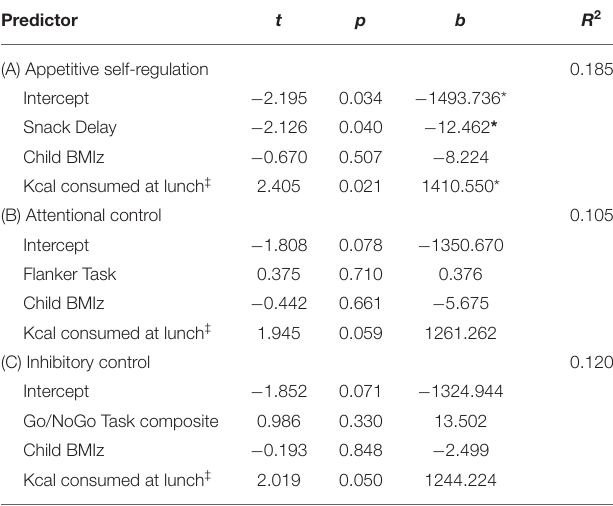
( Table 3B ), nor was inhibitory control, b = 13.50, 95% CI